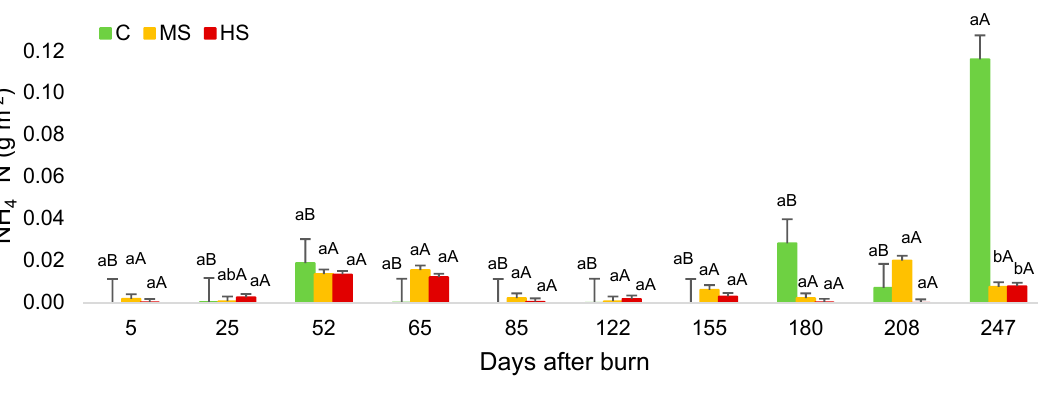
Figure 7. Treatment effect under control (C), moderate severity (MS), and high severity (HS) burn on NH 4— N loss between 5 and 247 days after pile burning. Mean values followed by the different lowercase letters show statistically significant differences within the same date. Mean values followed by the different uppercase letters show statistically significant differences within the same treatment. Significant differences were observed at p < 0.05. Hanging bars represent the standard error. ( n = 5). NO 3 -N loss was significantly di ff erent among treatments (F = 21.1, p < 0.0001), sampling dates